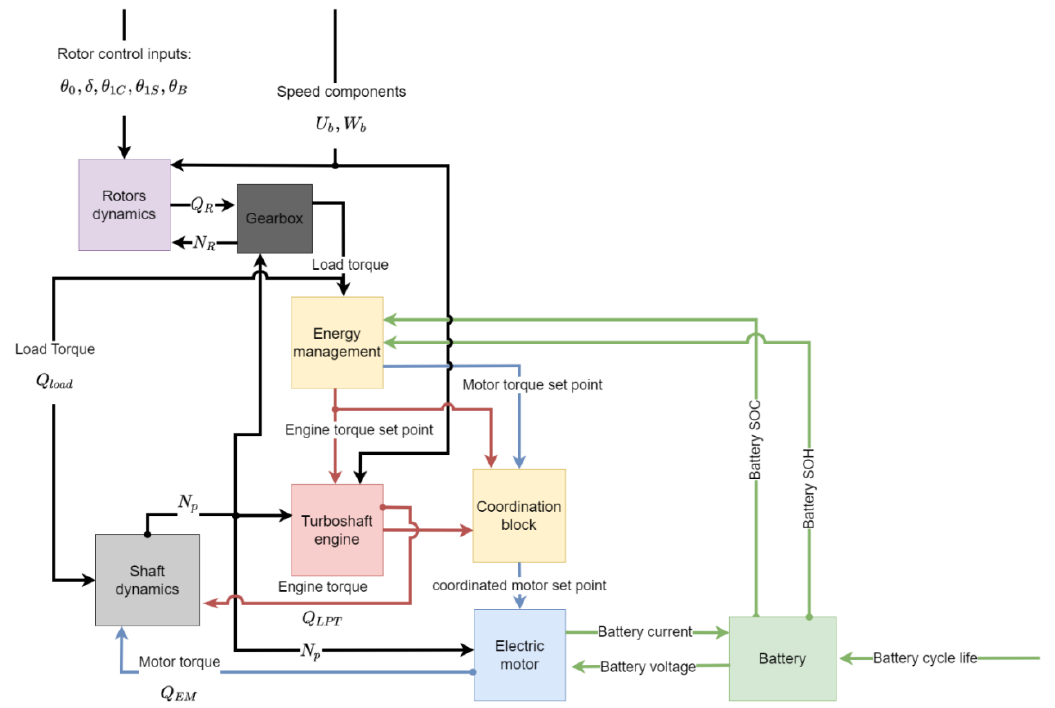
Figure 2. Flow chart of the whole model.